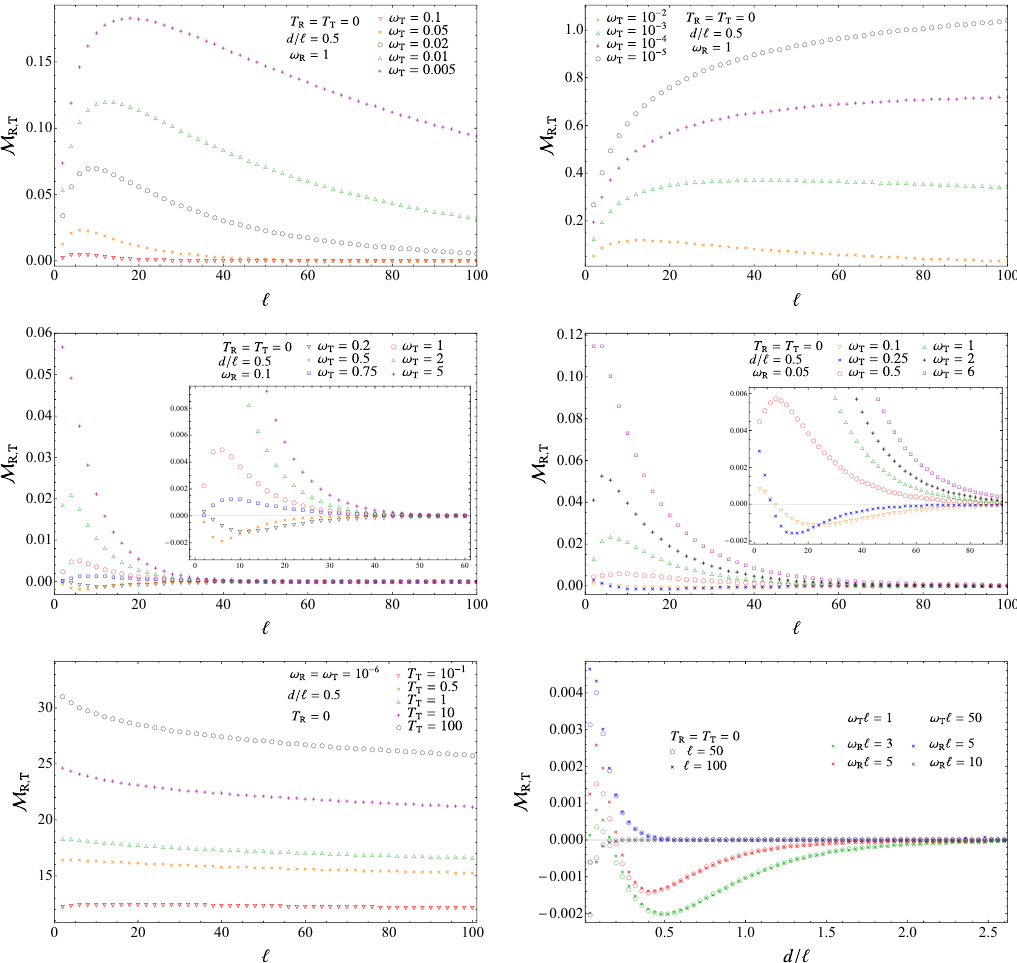
Figure 11 . The mutual complexity M separated by d sites in an infinite harmonic chain. Here κ = m = 1 , hence ˜ ω e T R = T R and e T T = T T . In the top panels, in the middle panels and in the bottom right panel the chain is in its ground state and ω are considered. In the bottom left panel, a case involving thermal states with T T > 0 is explored. The ratio d/‘ is kept fixed, except in the bottom right panel, where M T shown as function of d/‘